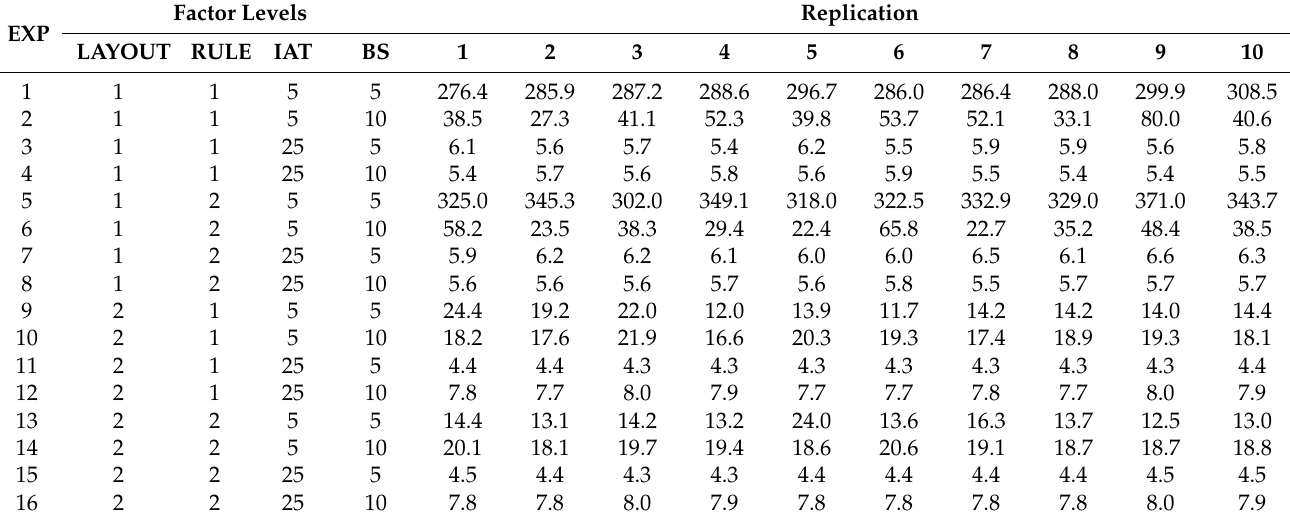
Table A2. WIP simulation results according to